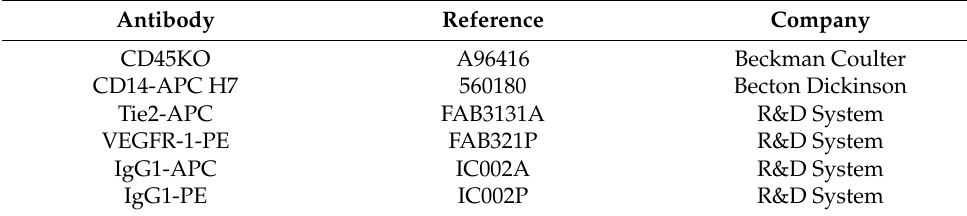
Table 1. Detail of the antibodies used in the human